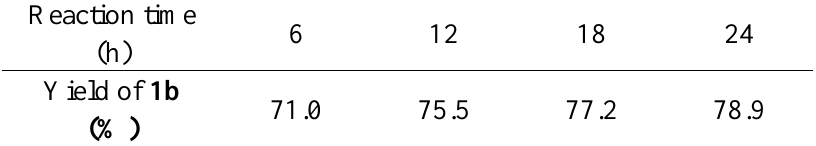
Table 3. Effect of reaction time on the yield of 1b in an oil bath.